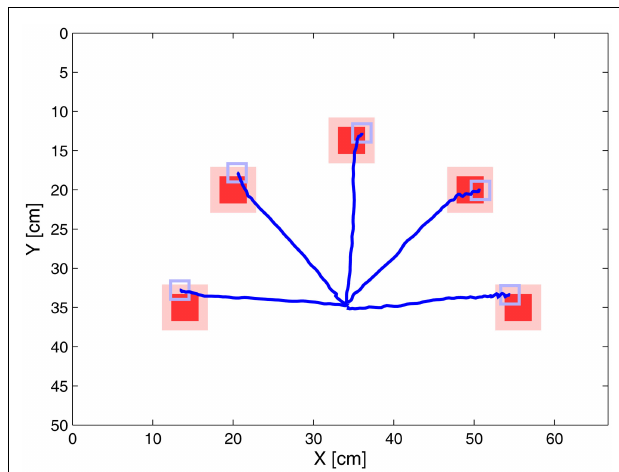
FIGURE 6 |Trajectories of the single target experiment. Targets of the reach movements are shown in red.When the arm reached at least the shaded area around the targets it was deemed to have reached the target. The gray square illustrates the size of the tip of the end effector.The base of the robot arm (shoulder) was positioned approximately 9cm under the starting point of the end effector.The end effector itself was located in the origin of the trajectories (35cm, 35cm).The robot arm was able to follow a quasi straight path to the target. All trajectories are mean trajectories of 5